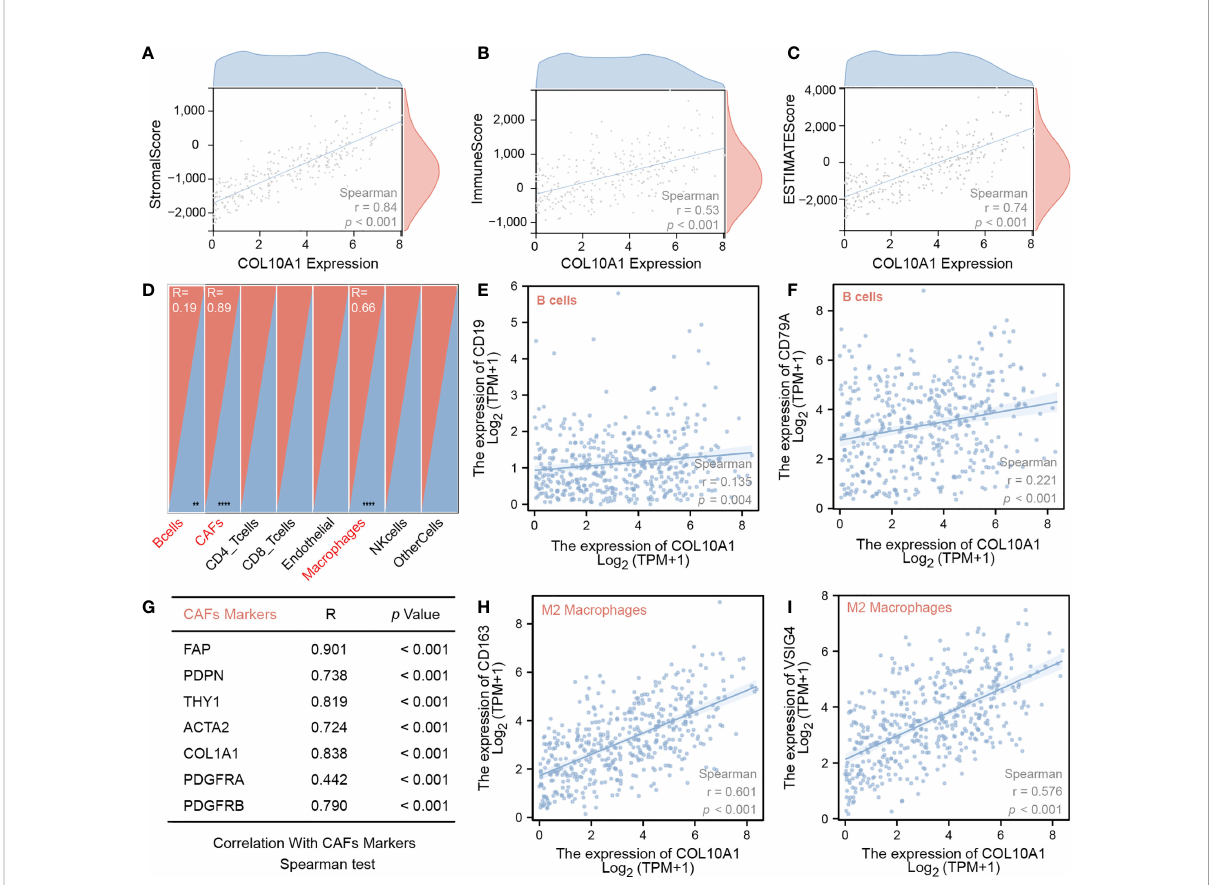
FIGURE 3 Spearman correlation test of COL10A1 mRNA levels and (A) stromal score, (B) immune score, (C) ESTIMATE score, (E) CD19, (F) CD79A, (G) different CAF cell markers, (H) CD163, and (I) VSIG4; (D) overview of correlation analysis of COL10A1 expression an several cell